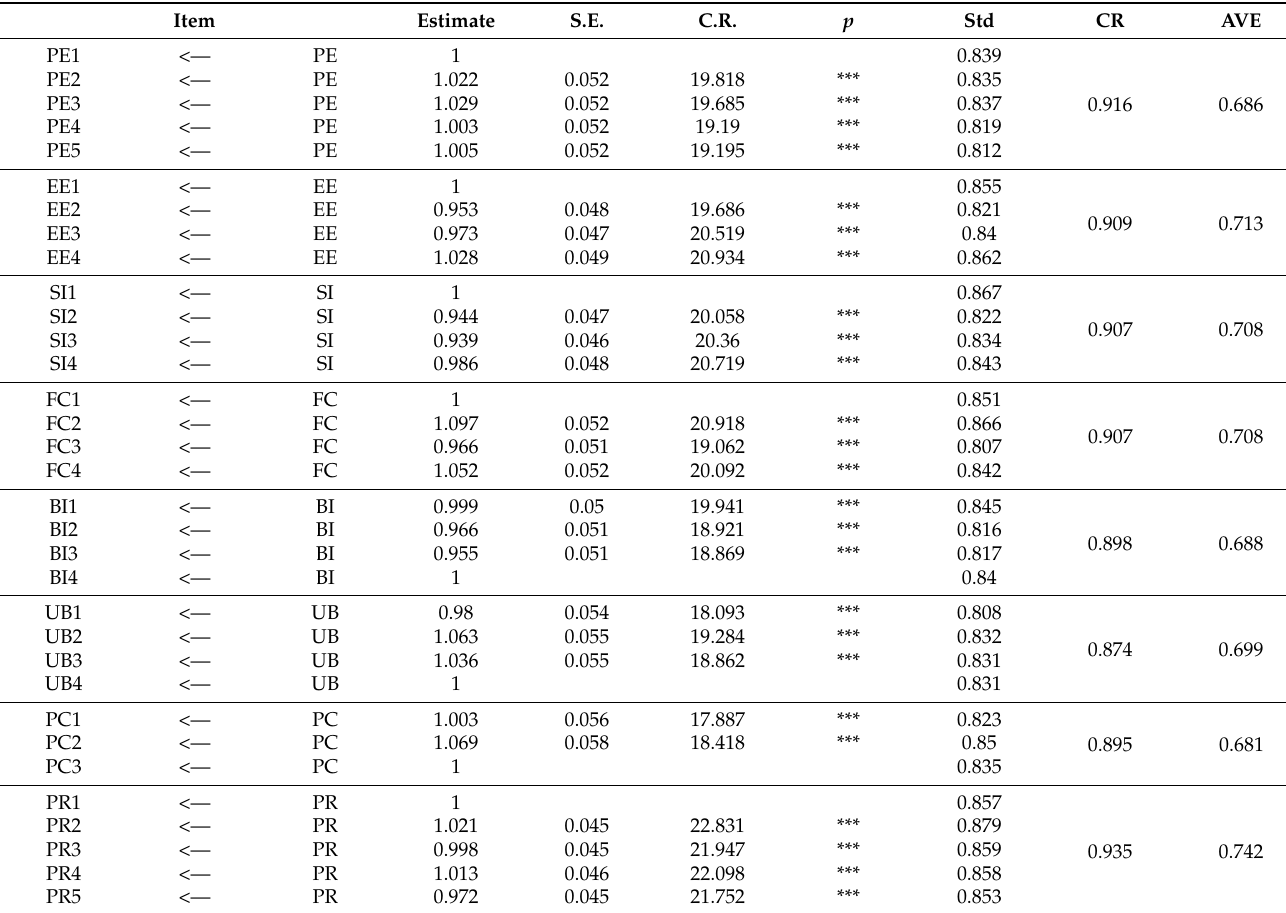
Table 6. Summary table of confirmatory factor